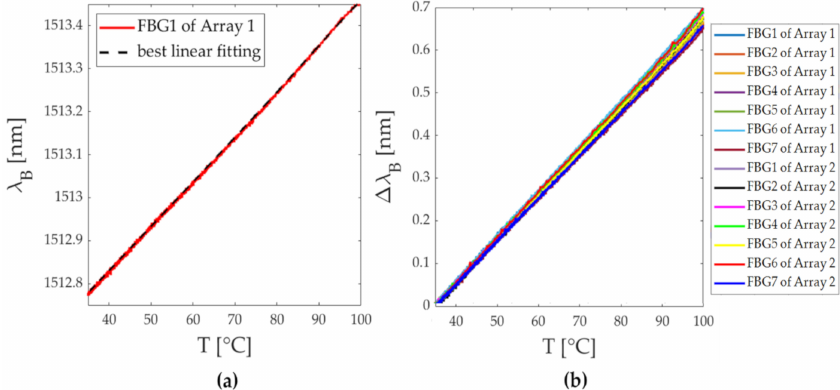
Figure 2. ( a ) The thermal response of the FBG 1 embedded in Array 1 (red line) and the best linear fitting (black dash line); ( b ) the temperature calibration curves of the fourteen FBGs embedded in Array 1 and Array 2.